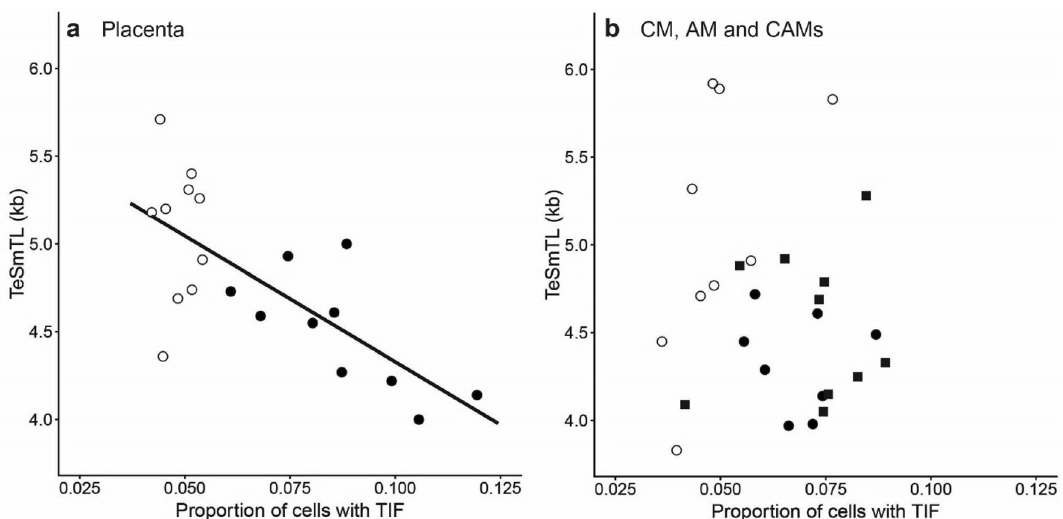
Figure 5. Correlation between telomere dysfunction induced foci (TIF) and TeSLA mTL (TeSmTL). Placenta ( a ); chorioamniotic membranes (CAMs) ( b ). For both panels ( a ) and ( b ) open data symbols: samples at 18-week gestation, filled data symbols: samples at term. For panel ( b ), chorionic membrane (CM, black circles), amniotic membrane (AM, black squares). For panel ( a ) correlation (R 2 = 0.52, n = 20, P < 0.001) between TeSmTL and proportion of TIF, and P = 0.41 (n = 27) for panel ( b